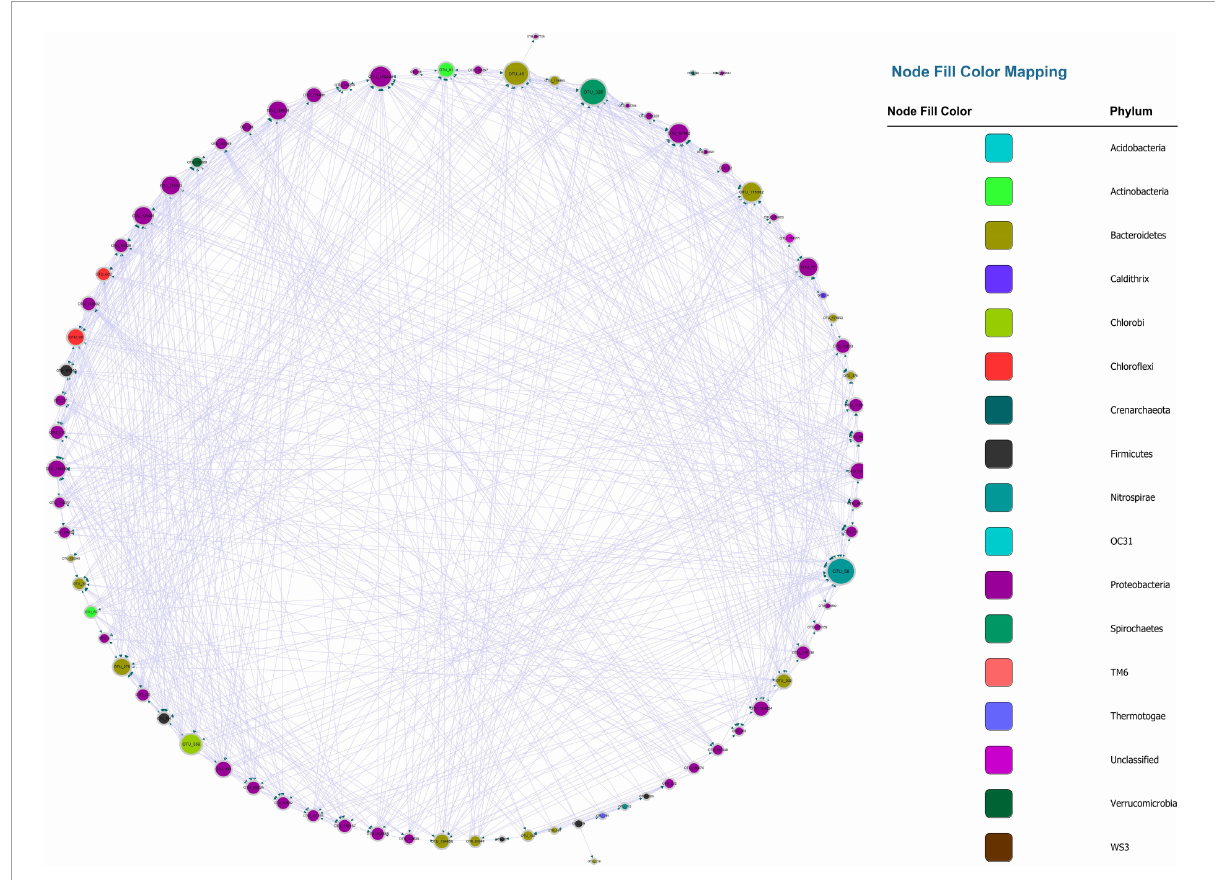
FIGURE3 Bonferroni-corrected MGCN, each color represents a separate phylum. The size of the node and node labels are proportionate to the edge number of each node from 0 to 110. The arrows represent the direction of Granger